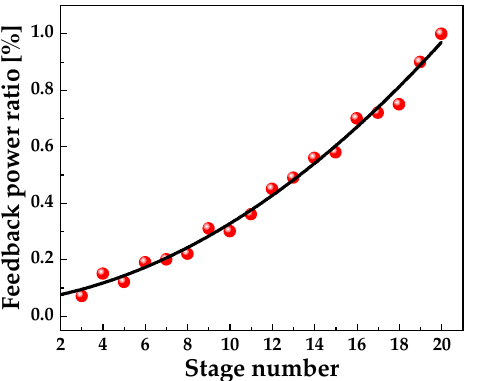
Figure 8. Hopf bifurcation point value vs. stage number m with I = 1.5 I th , τ f = 2.4 ns.